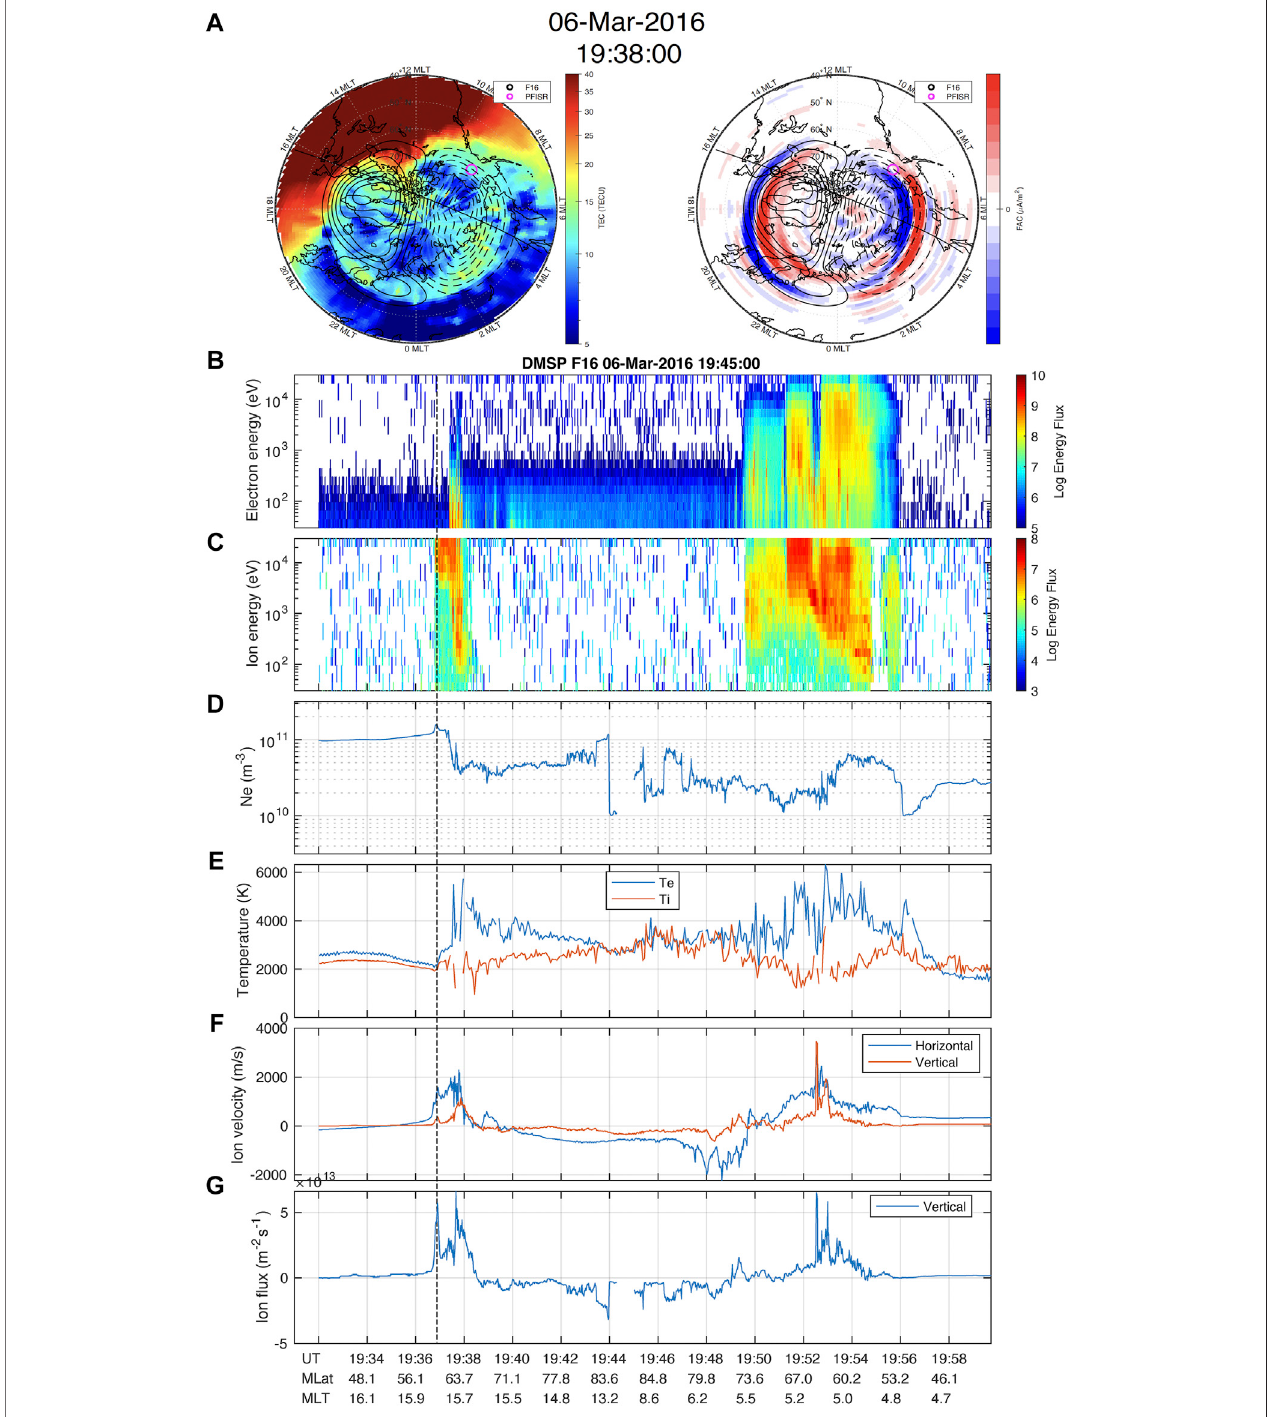
FIGURE9| DMSPF16measurementsfrom19:32to19:58UTonMarch06revealingtheSAPS-associatedup fl ow fl uxes.TEC/convection/FACpolarviewplotsat 19:38UTarealsoshownatthetop (A) .Fromtoptobottom,theDMSPobservationsincludeprecipitatingelectron (B) andproton (C) fl uxes,plasmadensity (D) ,electron (blue) and ion (red) temperature (E) , horizontal (blue) and vertical drift (red) (F) , and the vertical fl ux (G) , which is the product of plasma density and vertical fl ow. The trajectory of the DMSP satellite during this period is shown in the polar view plot.